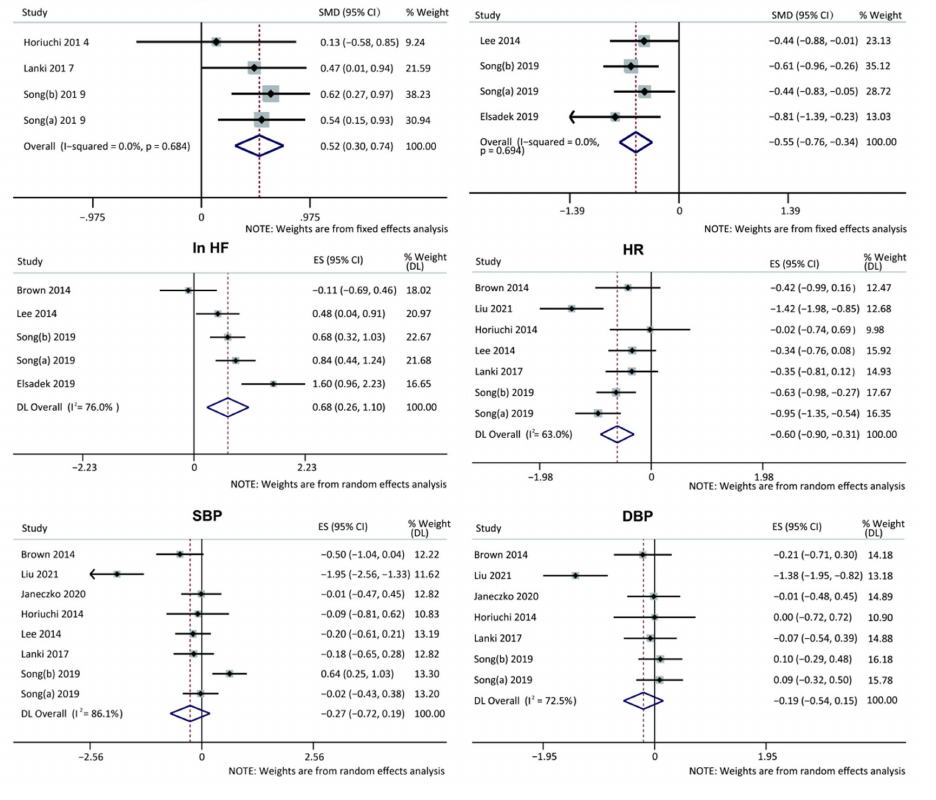
Figure 6. Forest plot of the meta-analysis of the relationship between green space exposure intervention and physiological indicators. Note. A heterogeneity test of the literature involved yielded I 2 = 0 <